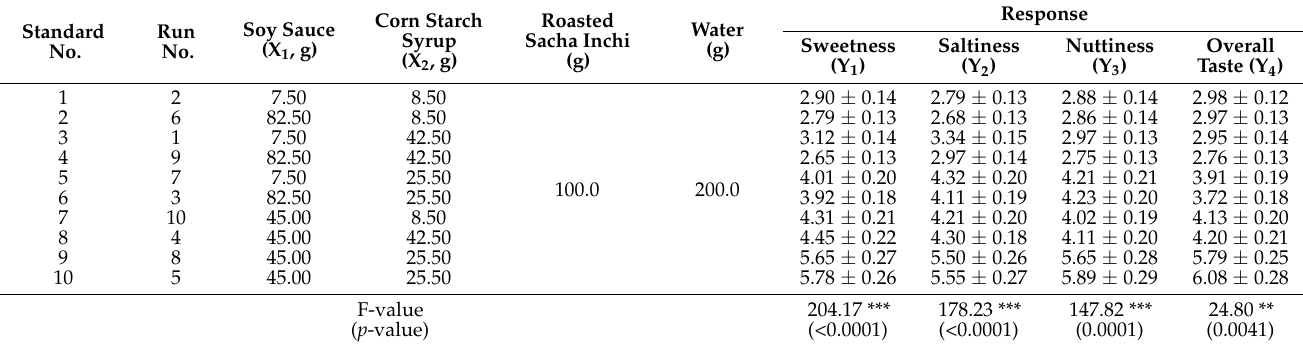
Table 1. Experimental design for response surface analysis and sensory properties of braised Sacha inchi. Standard